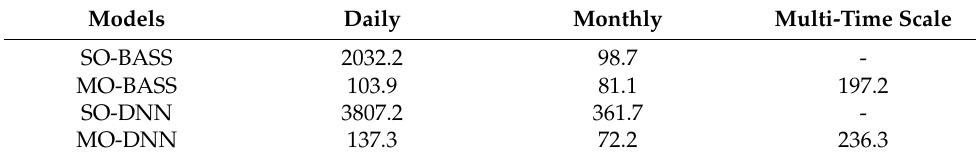
Table 3. The computational time of different time-scale cooling energy models (unit: s).